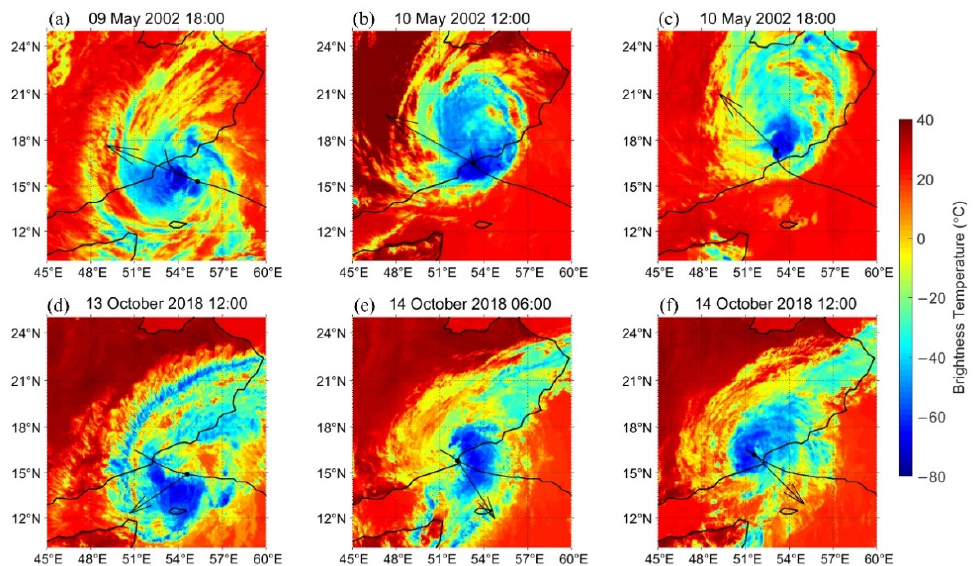
Figure 3. Brightness temperature ( ◦ C) distribution of ARB 01 on ( a ) 9 May 2002 18:00, ( b ) 10 May 2002 12:00, and ( c ) 10 May 2002 18:00, and Luban on ( d ) 13 October 2018 12:00, ( e ) 14 October 2018 06:00, and ( f ) 14 October 2018 12:00. The black arrow indicates the direction of the deep-level environment VWS.